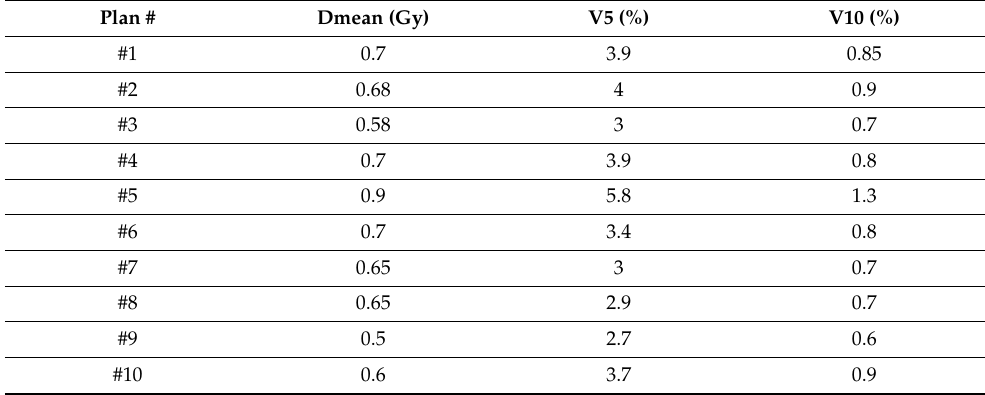
Table 4. Dosimetric parameters for normal